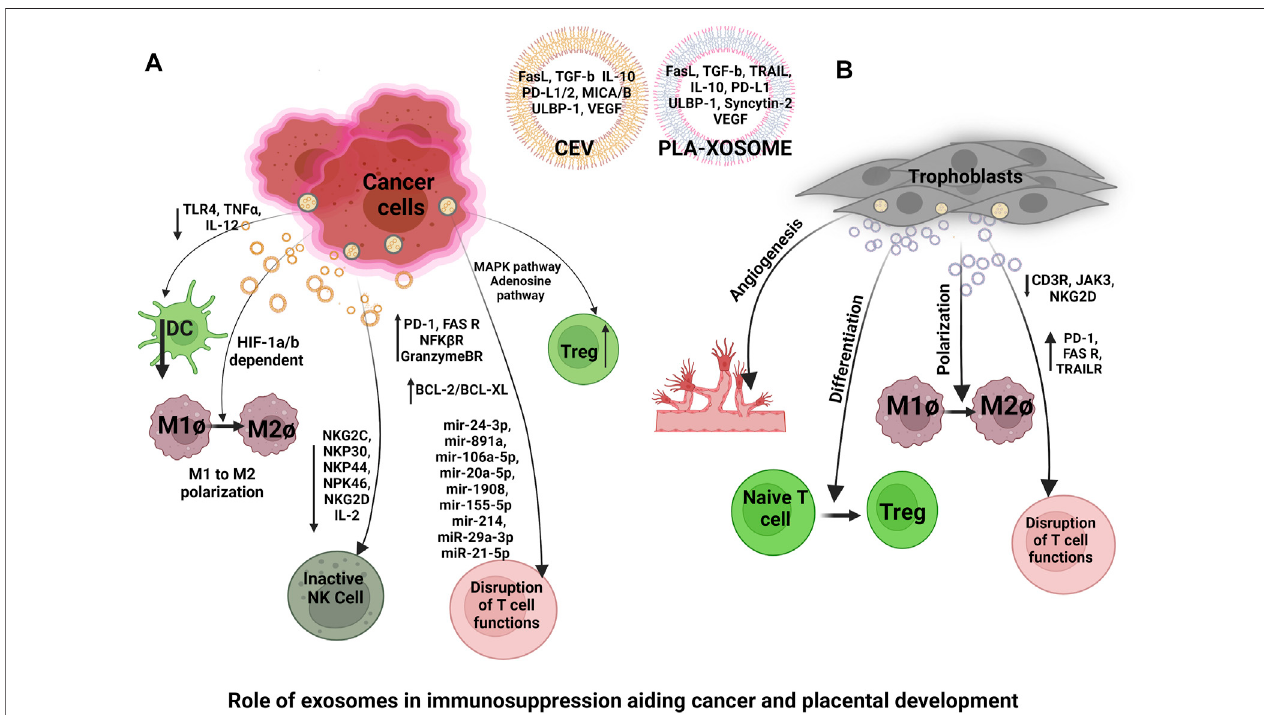
FIGURE 5 | Targets of cancer-derived exosomes (CEVs) and placenta derived exosomes (Pla-xosomes)- (A) CEVs contains mir-203 which downregulates expression of toll-like receptor 4 (TLR4), downstream tumor necrosis factor-alpha (TNF- α ) and interleukin-12 (IL-12) cytokines responsible for DCs proliferation and expansion, CEVscauses M1ØtoM2ØpolarizationinaHIF-1a and HIF-1bdependentmanner topromoteimmunesuppression, CEVs internalization inNK cells,inhibits the expression ofNK activating receptors like NKG2C, NKP30, NKP44, NPK46, and NKG2D to escape NK cell cytotoxicity, CEVs increases FasL/FasR signalling, PD-L1/PD-1 signalling and BCL2 (anti-apoptotic protein) expressions to evade apoptosis of cancer cells. CEVs carrying miR-29a-3p and miR-21-5p, miRNA 155-5p, miRNA-214,miR-24-3p,miR-891a,miR-106a-5p,miR-20a-5p,andmiR-1908inhibitsT-cellactivity,CEVsalsocauseTregexpansionthusaidingcancerdevelopment (B) Pla-xosomes promote angiogenesis via VEGF, help in Treg expansion, M2Ø polarization, causes upregulated expression of PD-L1, Fas, TRAIL and downregulates the expression of CD3 receptor, JAKR and NKG2D. All of these are essential to promote an effective immune microenvironment in the mother.